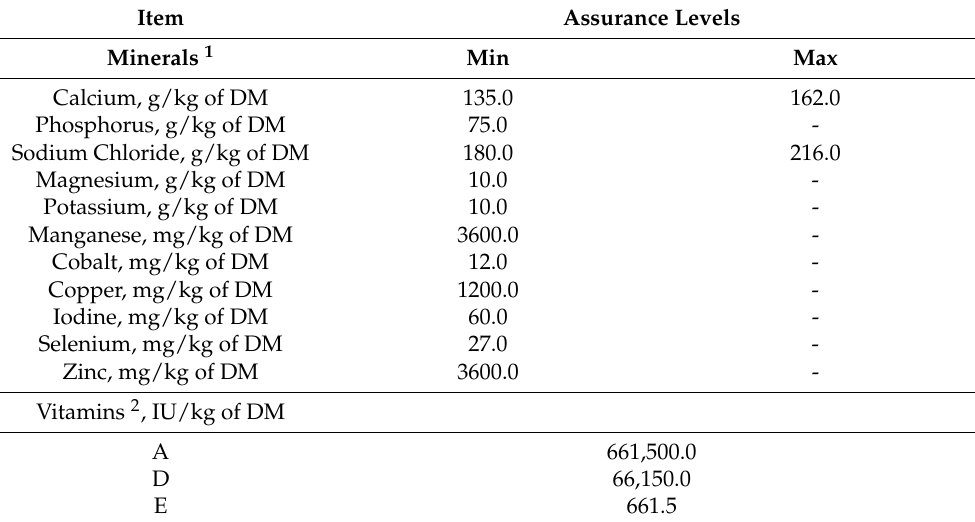
Table 1. Micronutrient composition of vitamin and mineral (VTM) supplement 1 provided to beef heifers during the first trimester of gestation; company guaranteed analysis.